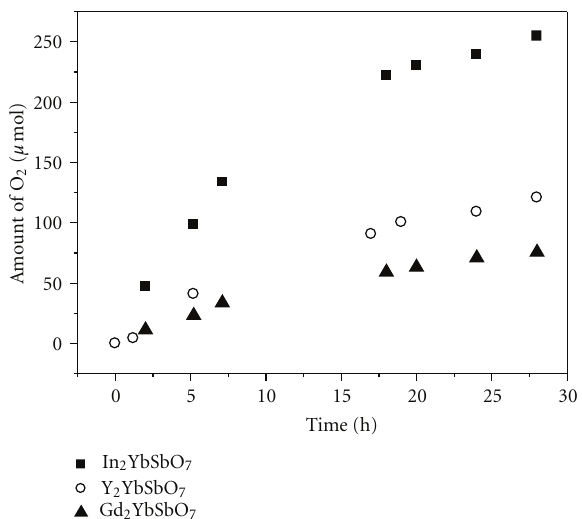
Figure 5: Photocatalytic H 2 evolution from aqueous methanol solution with Y 2 YbSbO 7 , In 2 YbSbO 7 , or Gd 2 YbSbO 7 as catalyst under visible light irradiation (390nm cut-o ff filter, 0.5g 0.1 wt% Pt-loaded powder sample, 50mL CH 3 OH, 200 mL pure